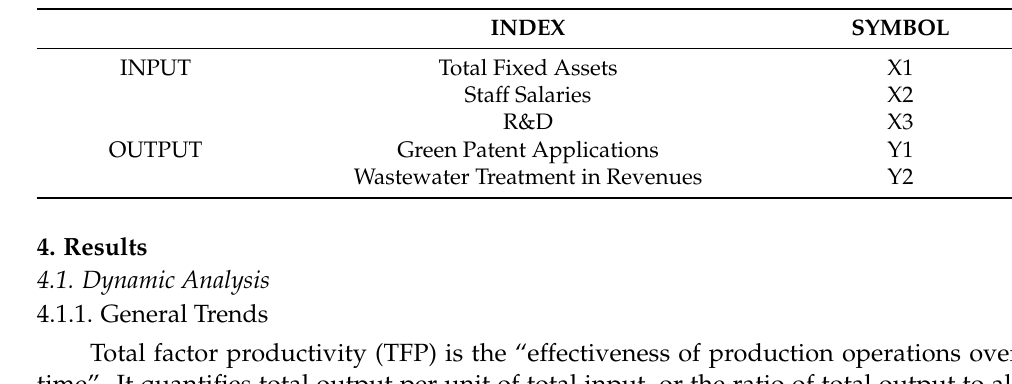
Table 2. Input and output